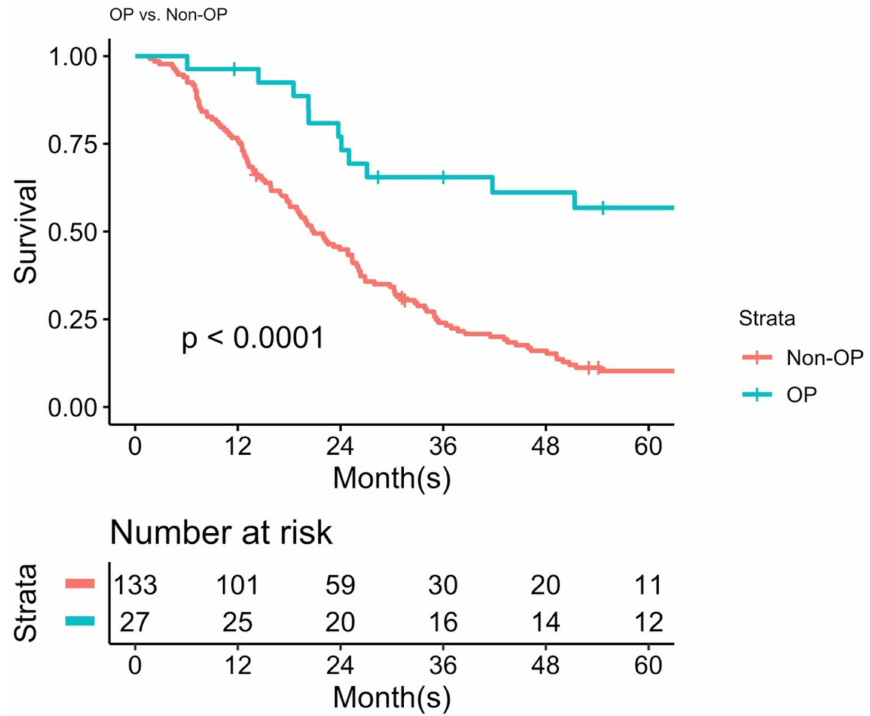
Figure 4. The difference in post-recurrence overall survival (PROS) between the patients who underwent repeat operation and those who did